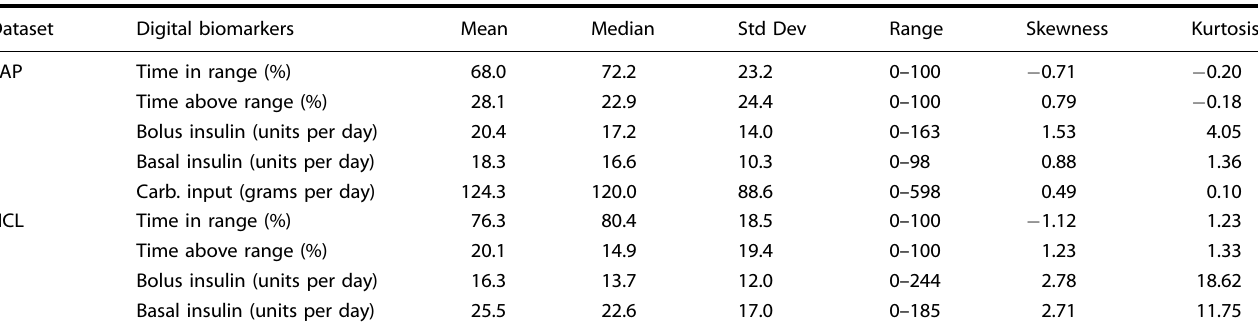
Basal insulin (units per